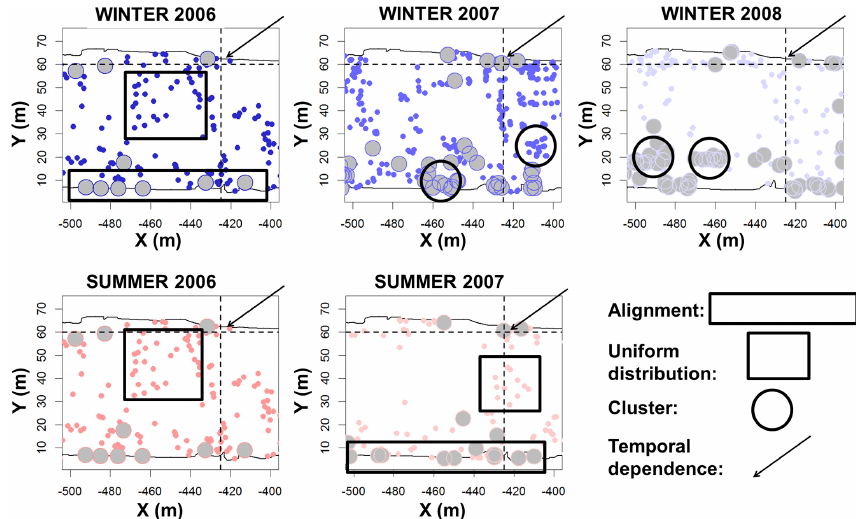
Figure 4. Zoom on the cliff (located between x = − 500m and x = − 400m, see Fig. 1b). The erosion scars are outlined by different colours, each of them corresponding to a different epoch of measurement (see Table 1 for more details). Small erosion scars (volume ranging from 10 − 3 to 10 − 2 m 3 ) are outlined by plain dots, whereas large scars (volume ranging from 10 − 2 to 10 1 m 3 ) are outlined by grey-coloured dots. Black-coloured marker outlines regions, where observations might suggest specific spatial patterns (see text for